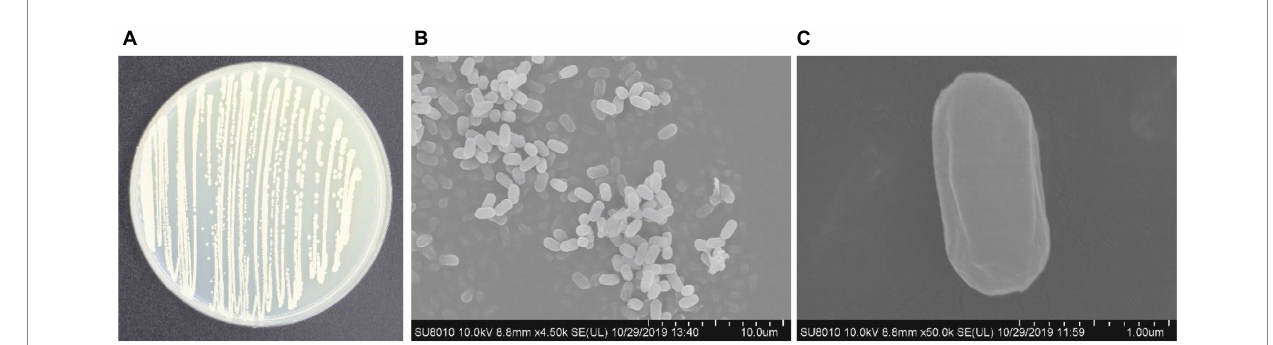
FIGURE 3 Morphological features of B. subtilis Y17B. (A) Colony morphology. (B) Bacterial cells in chain form. (C) Single bacterium. Scale bars: 10 μ m (B) ; 1 μ m (C)